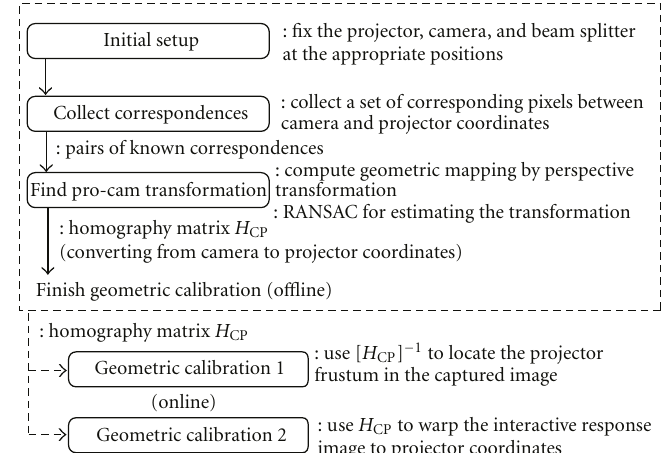
Figure 3: Procedural flow of the proposed scene-independent pro-cam geometric calibration during o ffl ine and online